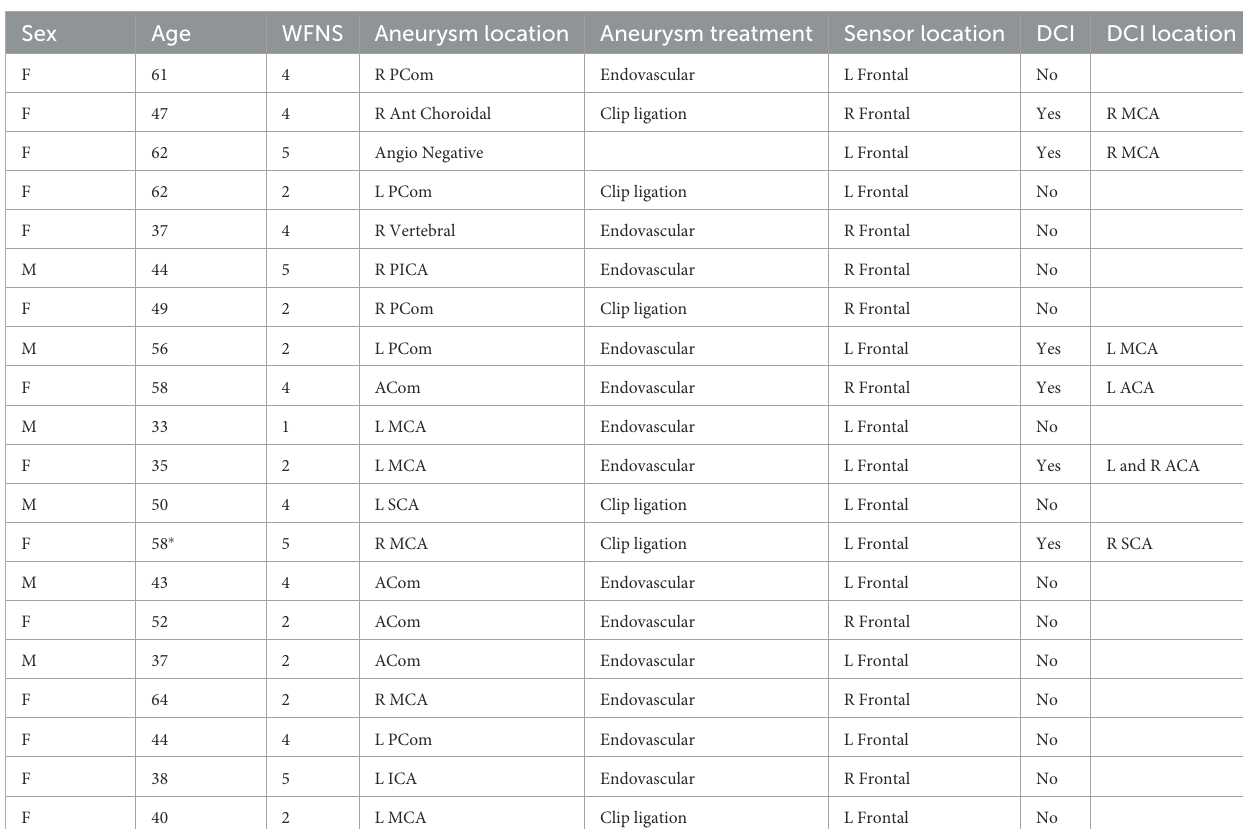
TABLE 2 Summary of patient demographics and clinical